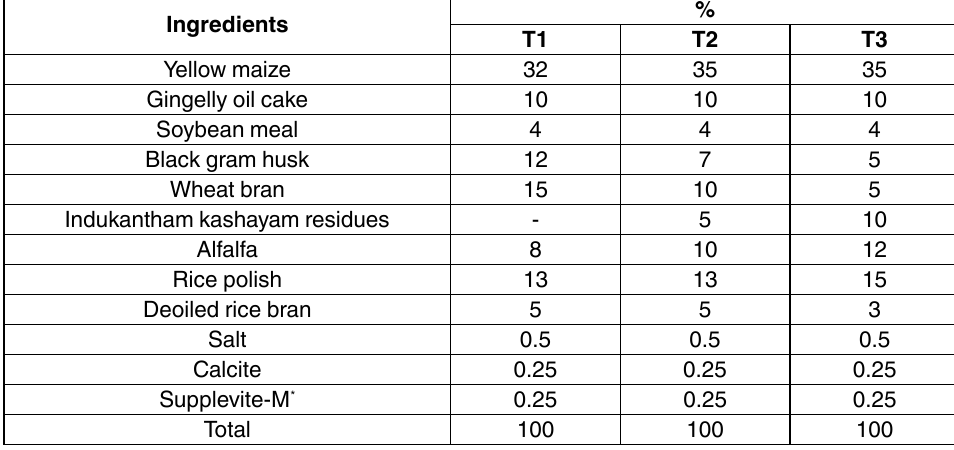
table 1. Ingredient composition of experimental diets, %